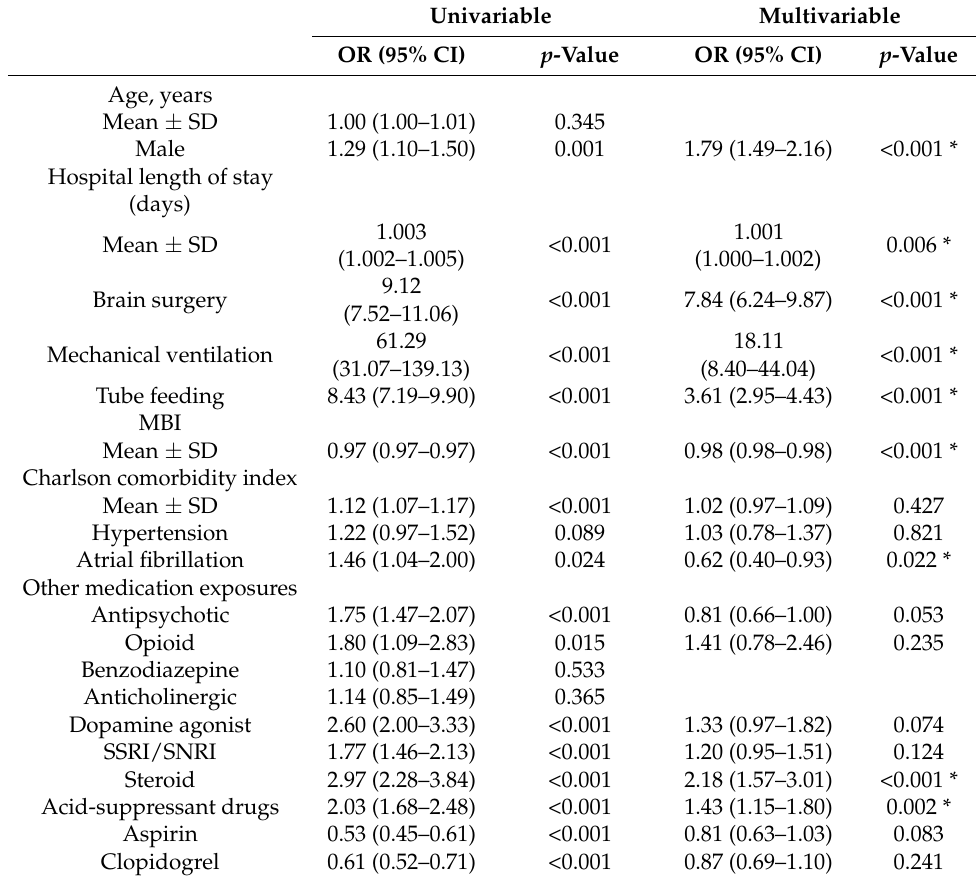
Table 2. Univariable and multivariable logistic regression associated with